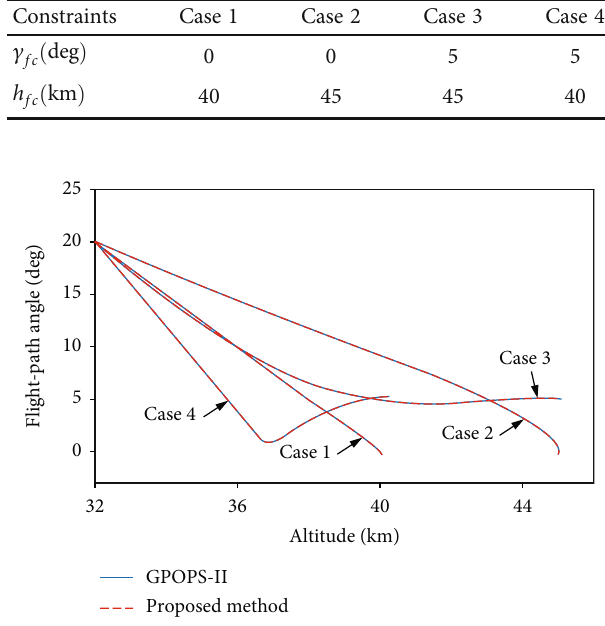
Figure 5: Altitude vs. fl ight-path angle histories.